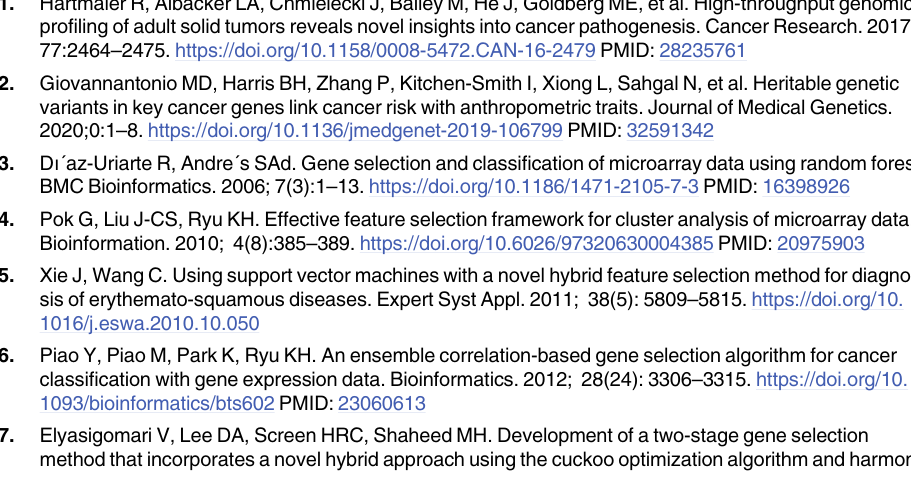
S1 Table. Gsea_report_for_Tumor_and_Normal. S2 Table. The 60 genes listed in descending order of importance. S3 Table. Genes sorted in a descending order in 19 iterations. S4 Table. Information about survival of patients. S5 Table. Genes sorted by SDBE algorithm in descending order (Pre_SDBE). S6 Table. Classification performance information of three advanced algorithms (PSO, GA, and COA-HS) for three cancer